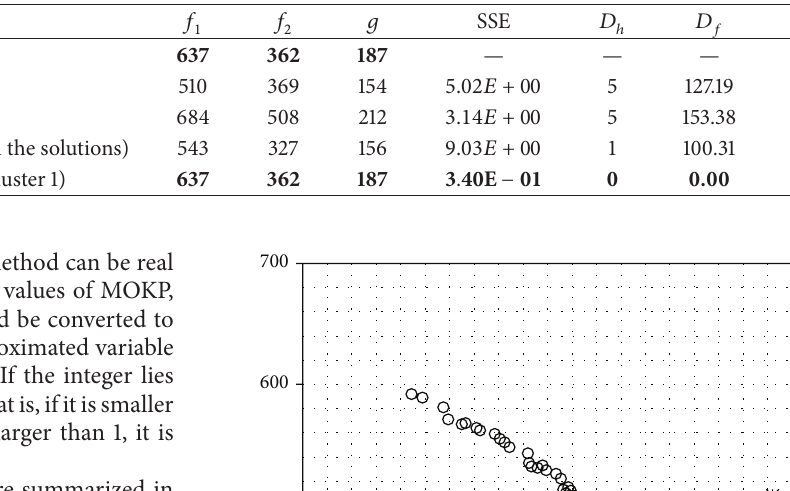
Table 2: Summary of design approximation using design modes.